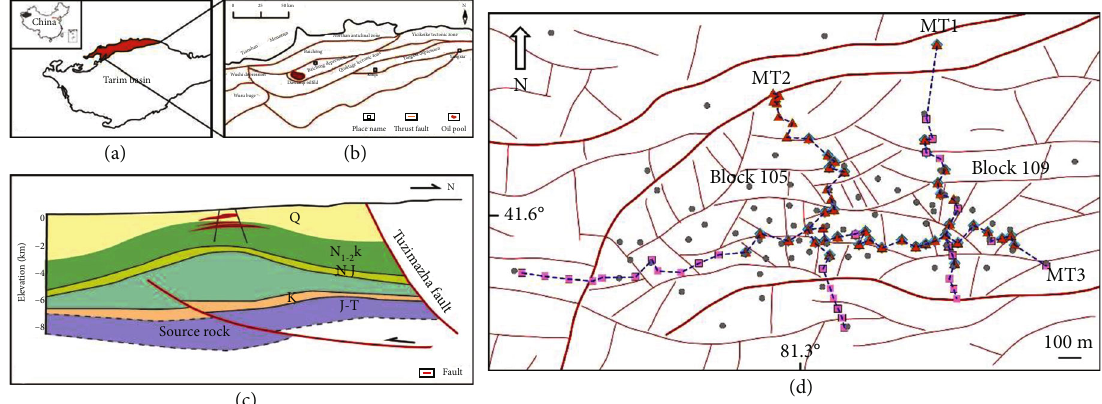
Figure 2: (a) Location of Tarim Basin. (b) Location and strata structure of Dawanqi oil fi eld. (c) Diagram of Dawanqi oil fi eld section. (d) Gas fl ux measurement locations at the Dawanqi oil fi eld. Red lines are fault and fracture systems identi fi ed by geophysical prospections [18]. Gray circles are oil wells. Triangles (August 2014), diamonds (January 2015), and squares (August 2019) are the measurement sites of each measurement campaign.